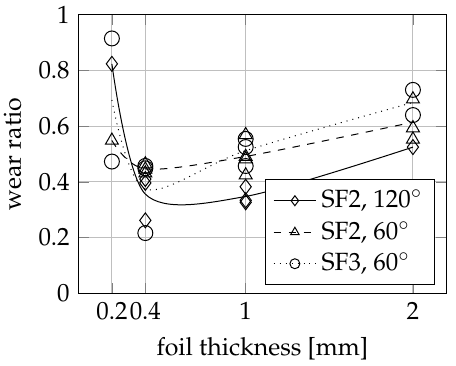
Figure 16. Average ratio of resulting wear due to material loss to total wear over foil thickness for rub scenario S3, both seal fin geometries and foil orientations.